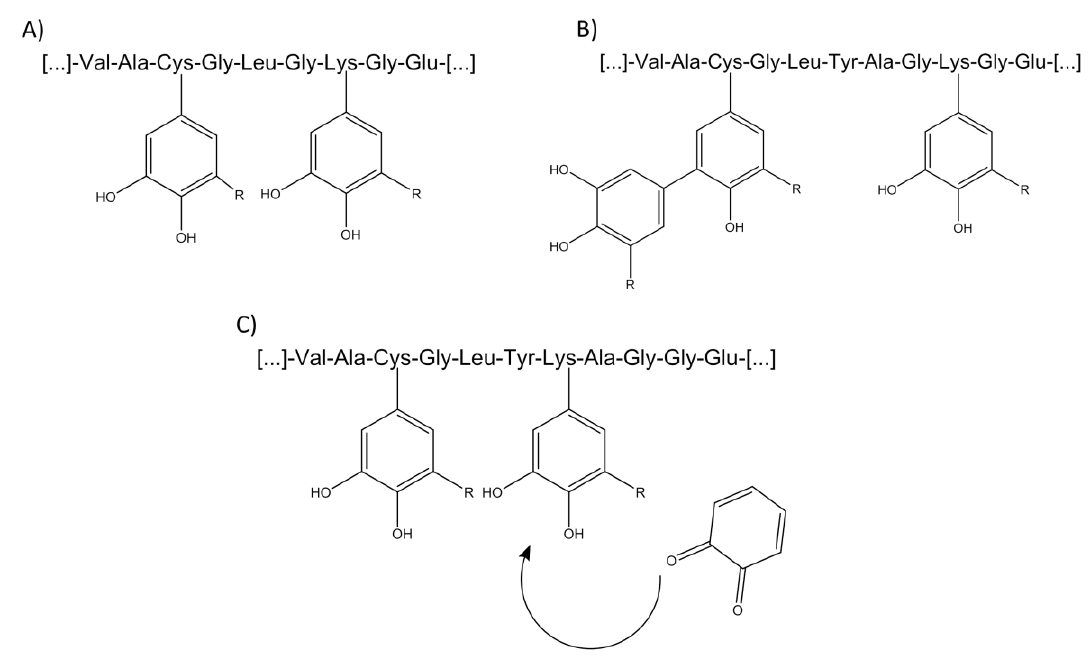
Figure 4. Varying reaction possibilities between peptides and phenolic compounds. ( A ) monomeric phenolic compound bound to a single amino acid residue of a peptide; ( B ) binding of different polymerization products of phenolic compounds to a peptide; ( C ) further reaction between bound phenolic compound with a further activated phenolic compound.